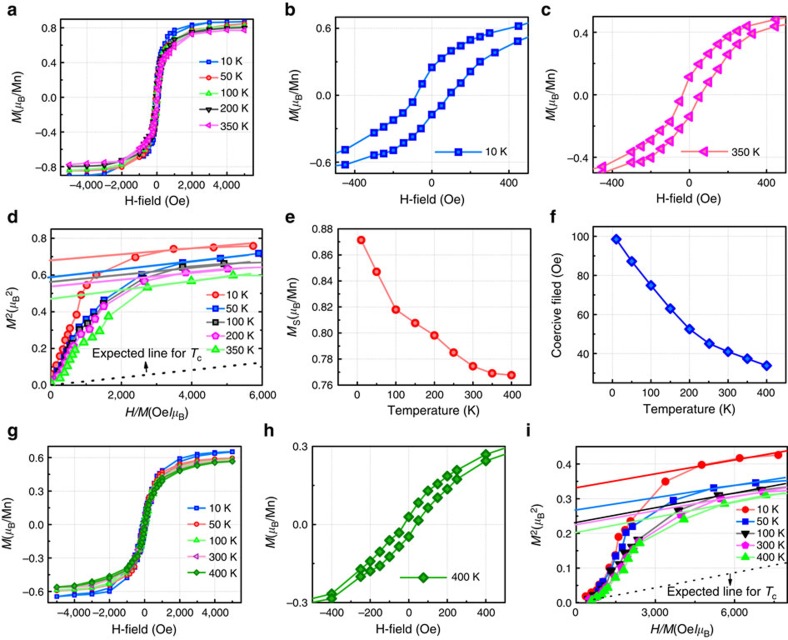
Magnetic properties of MnxGe1−x nanomeshes.(a) Magnetic hysteresis loops of the Mn0.03Ge0.97 nanomeshes measured at different temperatures from 10–350 K. (b,c) The magnified hysteresis loop obtained at 10 and 350 K, respectively. (d) Arrott's plots showing that the Tc is above 350 K. (e) The temperature-dependent saturation moment. (f) Temperature-dependent coercivity decreasing from 100 Oe at 10 K to 35 Oe at 400 K. (g) Temperature-dependent M–H curves of the Mn0.05Ge0.95 nanomeshes. (h) The magnified hysteresis loop obtained at 400 K. (i) Arrott's plots showing that its Tc is above 400 K.